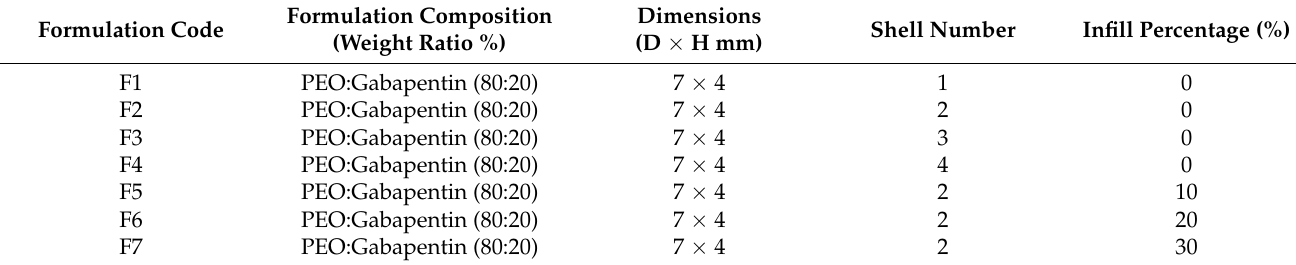
Table 2. Formulation composition, dimension, and printing parameters of tablets.